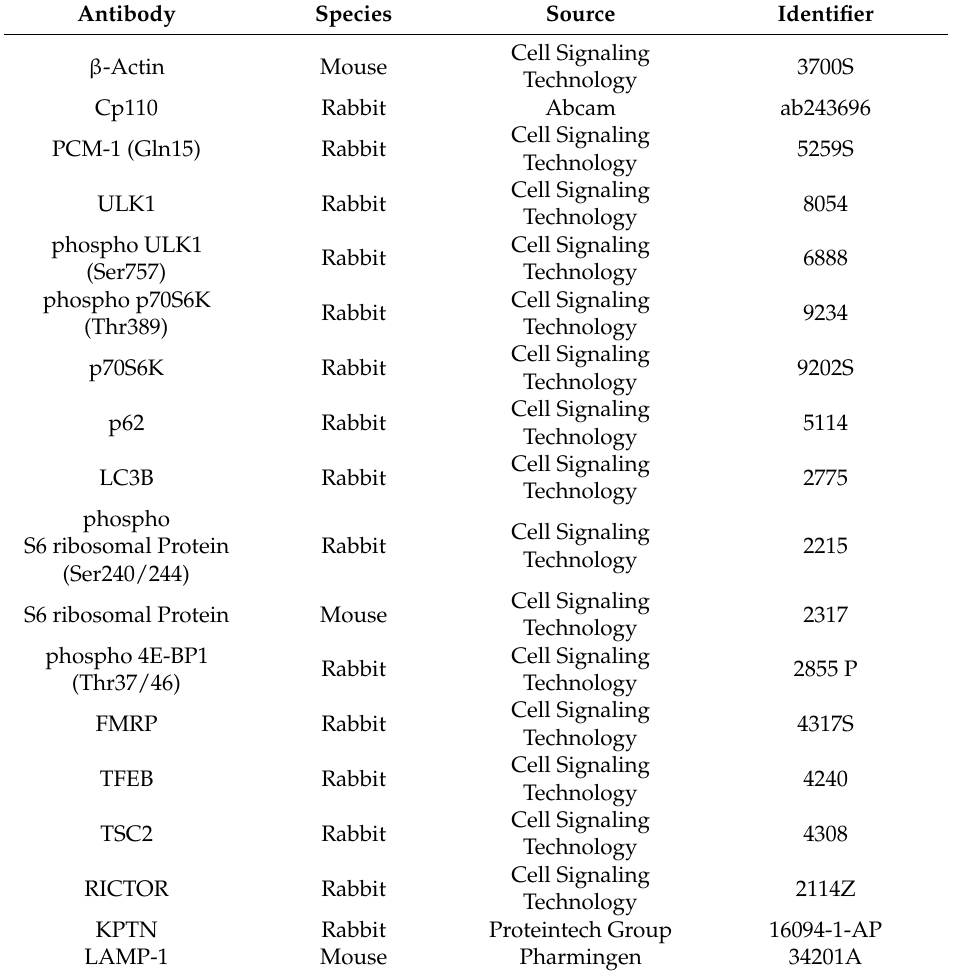
Table 2. List of the antibodies